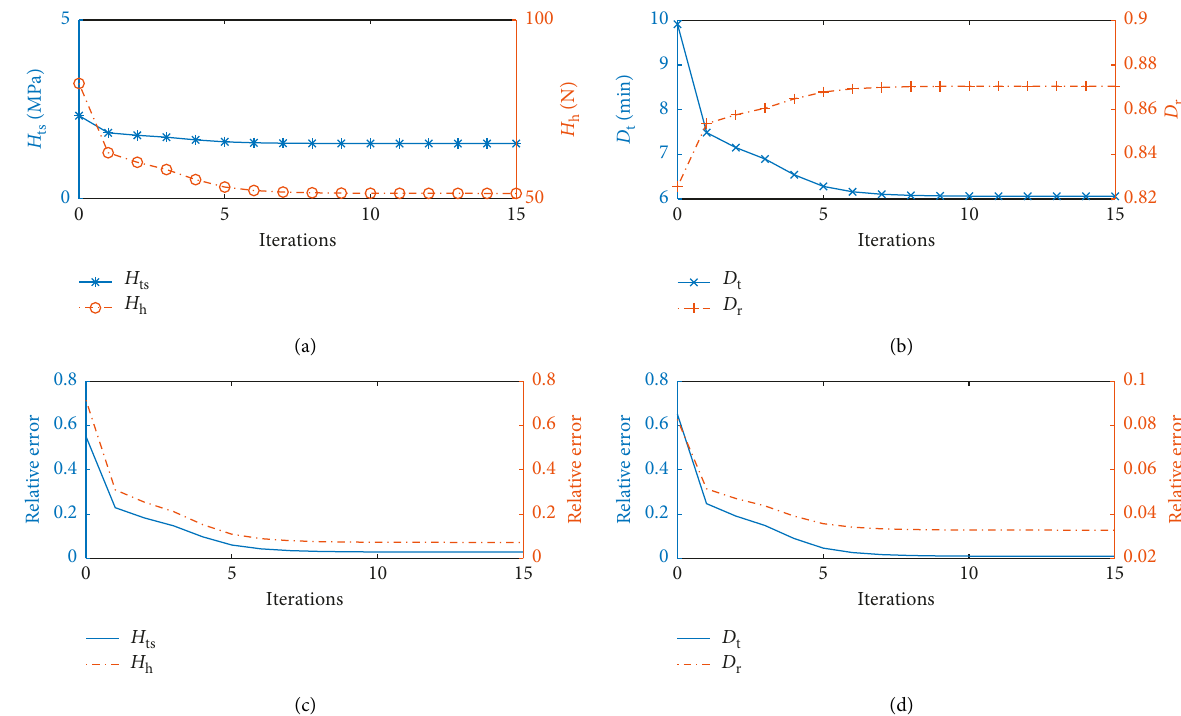
Figure 14: The simulation results of tablet quality indexes for process quality